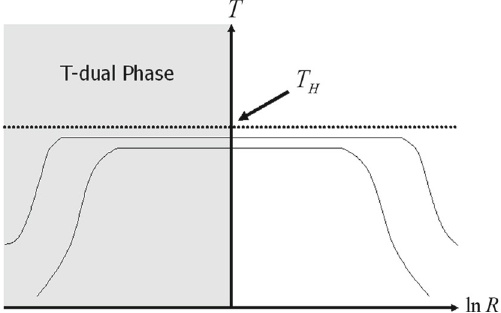
Fig. 5 Evolution of the temperature (vertical axis) as a function of the logarithm of the radius (horizontal axis). Two possible evolution- ary tracks are shown which differ in the amount of entropy which they contain. If we begin the evolution at large radii, then initially the tem- perature rises as space contracts as for point particle matter. However, once the temperature approaches the limiting Hagedorn temperature T H ,thetemperatureceasestoriseas R decreases.Belowacriticalradius which is chosen to be one in the figure, the temperature decreases as R decreases